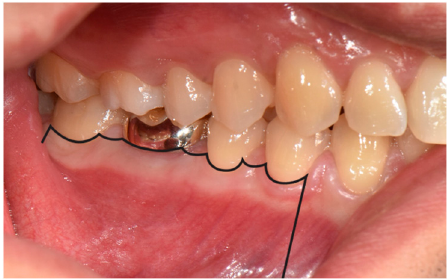
Figure 9. Papilla base incision (black line), creating access to the mandibular first molar.